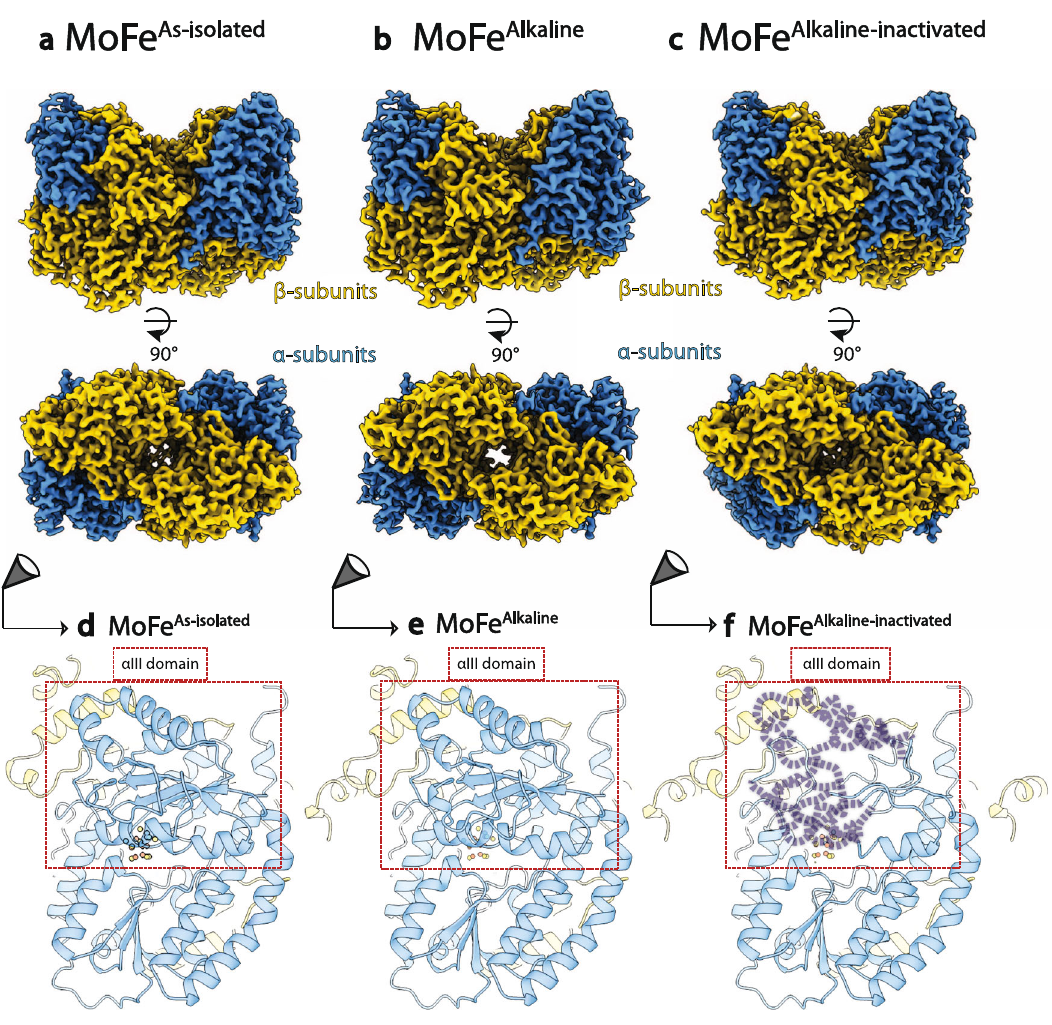
Fig. 1 | Anaerobic cryoEM structures of MoFe-protein. a The 2.13Å resolution cryoEM map of MoFe As-isolated puri fi ed from A. vinelandii . b The 2.14Å resolution cryoEM map of MoFe Alkaline from a control acetylene reduction reaction performed at pH 9.5 without ATP isolated via S.E.C. conducted at pH 7.8, demonstrating the same overall architecture as MoFe As-isolated . c The 2.37Å resolution cryoEM map of MoFe Alkaline-inactivated from an acetylene reduction reaction performed at pH 9.5 with